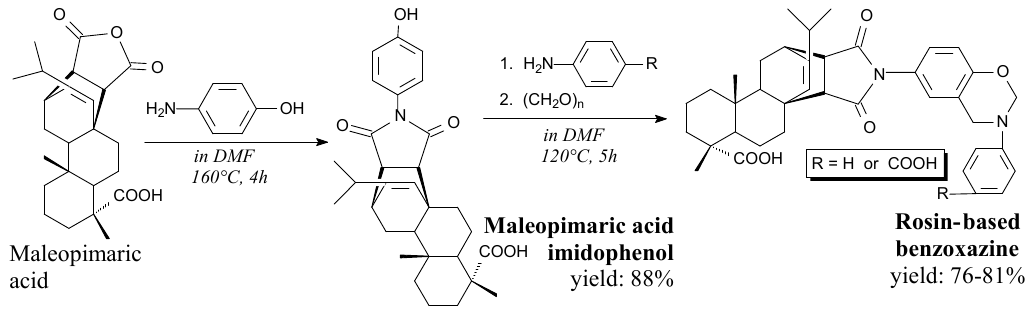
Scheme 20. Synthesis of maleopimaric acid imidophenol and its benzoxazines.